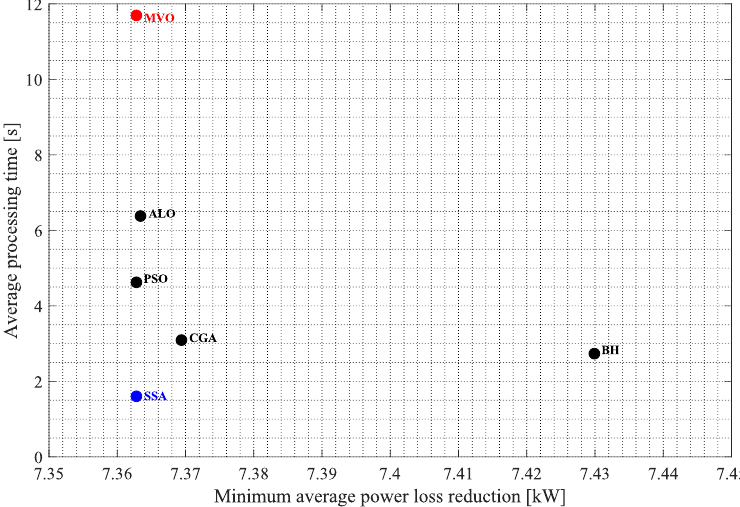
Figure 6. Trade-off provided by the solution methodologies between average minimum power losses and required processing time in the 21-node